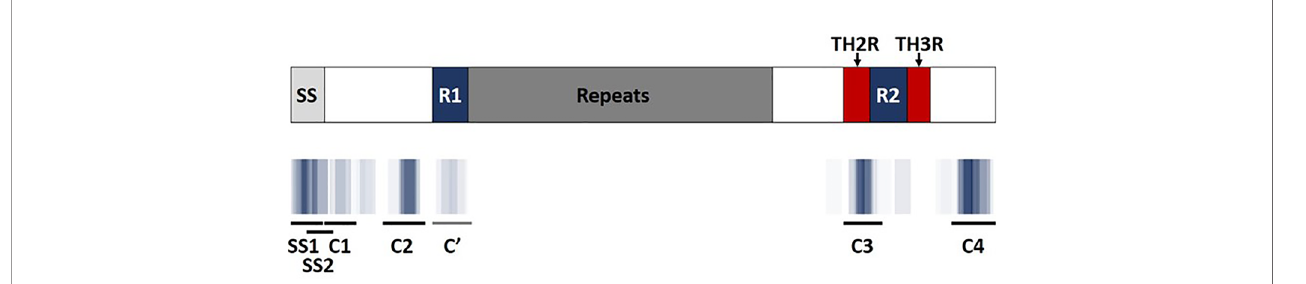
FIGURE 2 | EpiMatrix predicted class II T cell epitope coverage for PfCSP 3D7. Major regions of PfCSP (top) are shown aligned with predicted class II T cell epitope clusters (bottom). Areas of darker blue indicate higher numbers of predicted epitopes while white areas indicate a lack of predicted epitopes. ClustiMer outputs are shown as black and grey lines where C1-C4 represent the four identi fi ed epitope clusters, non-inclusive of the two predicted clusters overlapping the signal sequence (SS). C ’ represents a pseudo-cluster containing only a few predicted epitopes. The repeat region, highly conserved regions (R1 and R2), and highly variable regions (TH2R and TH3R) of CSP